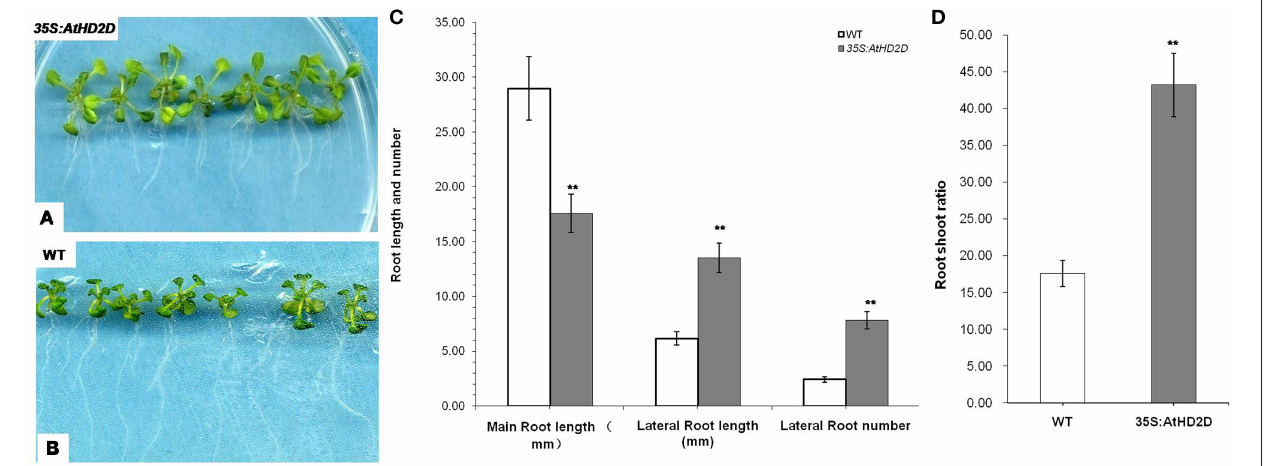
FIGURE 5 | Root development of wild-type and 35S:AtHD2D transgenic plants. The error bars represent the SD . The data are presented as the mean ± standard deviation of the mean ( SD ) and were tested for significant difference using Student’s t -test ( ** p < 0.01 ). (A,C) Roots of wild-type (WT) 10 days after germination. (B,D) Phenotype of roots and leaves of 35S:AtHD2D of transgenic seedlings 10 days after germination. (E) Root and shoot ratio of WT and 35S:AtHD2D transgenic plants 10 days after germination on MS medium. (F) Root length and root number of WT and 35S:AtHD2D transgenic